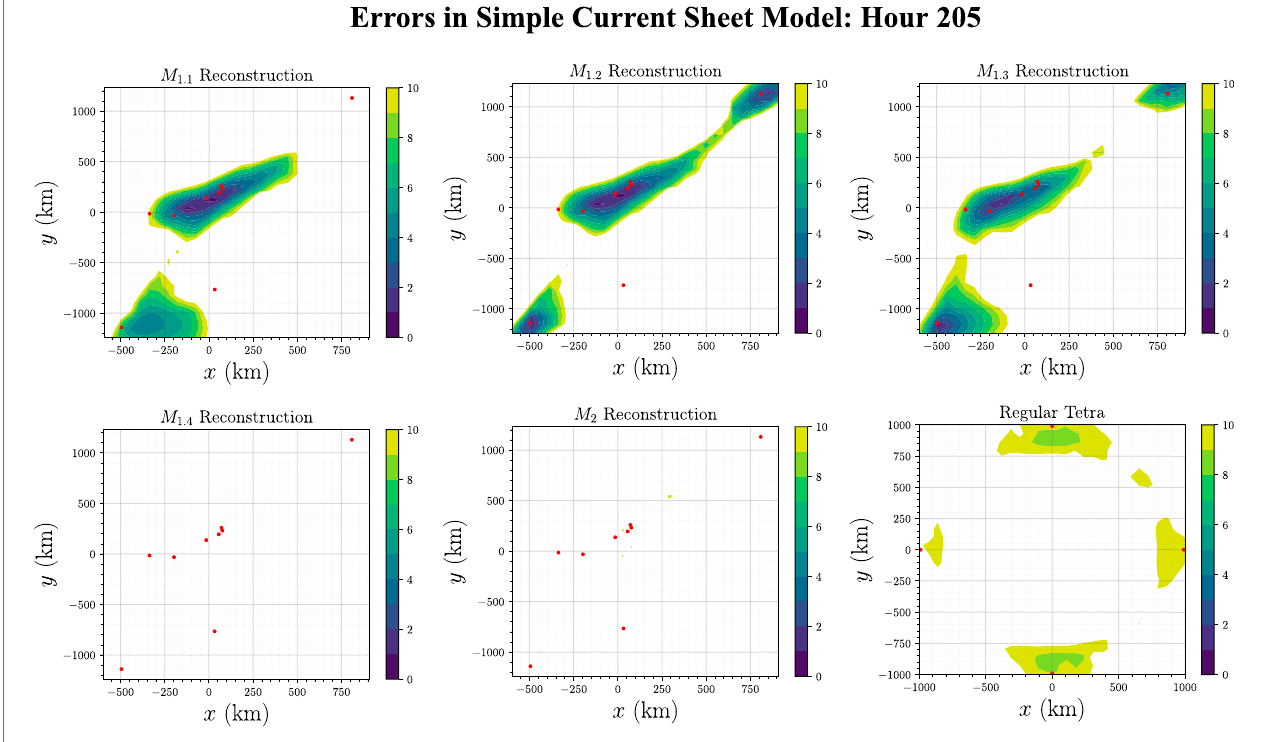
FIGURE6 | Computation error(de fi ned in Eq. 7 ) at all points on the z (cid:1) 0plane ofthe simple current sheet model, using theswarm con fi guration at hour205 ofthe HelioSwarm DRM. The layout is identical to Figure 4 .